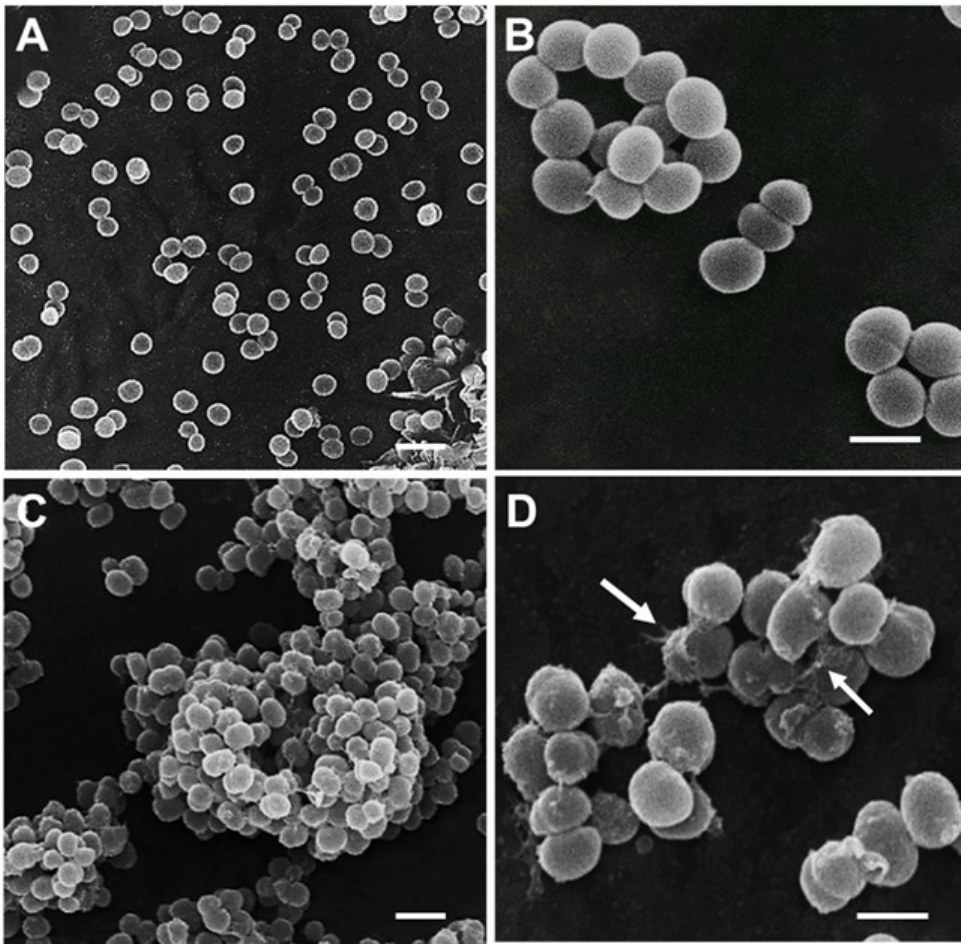
Figure 5. SEM micrographs of the MRSA / VISA CIP 106760 strain. A , B —Control bacteria. C —Bacteria treated with AHR at MIC / 2, D —Bacteria treated with AHR at MIC showing localized cell wall disruption (arrows). Scale Bars: 4 µ m (A, C); 1 µ m (B, D).